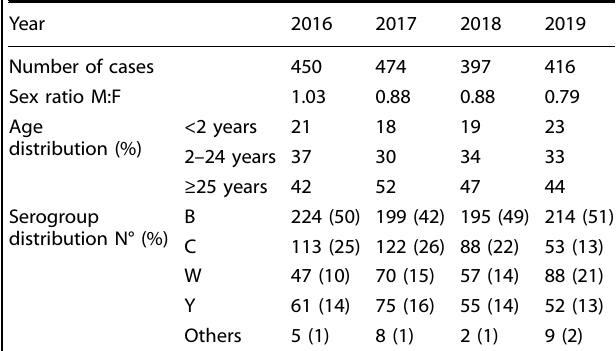
Table 1. General characteristics of IMD cases during the period 2016 – 2019.